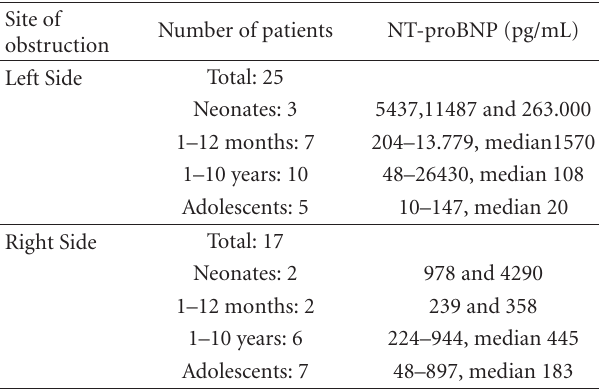
Table 4: Comparison of patients with left-sided obstruction and right-sided obstruction.